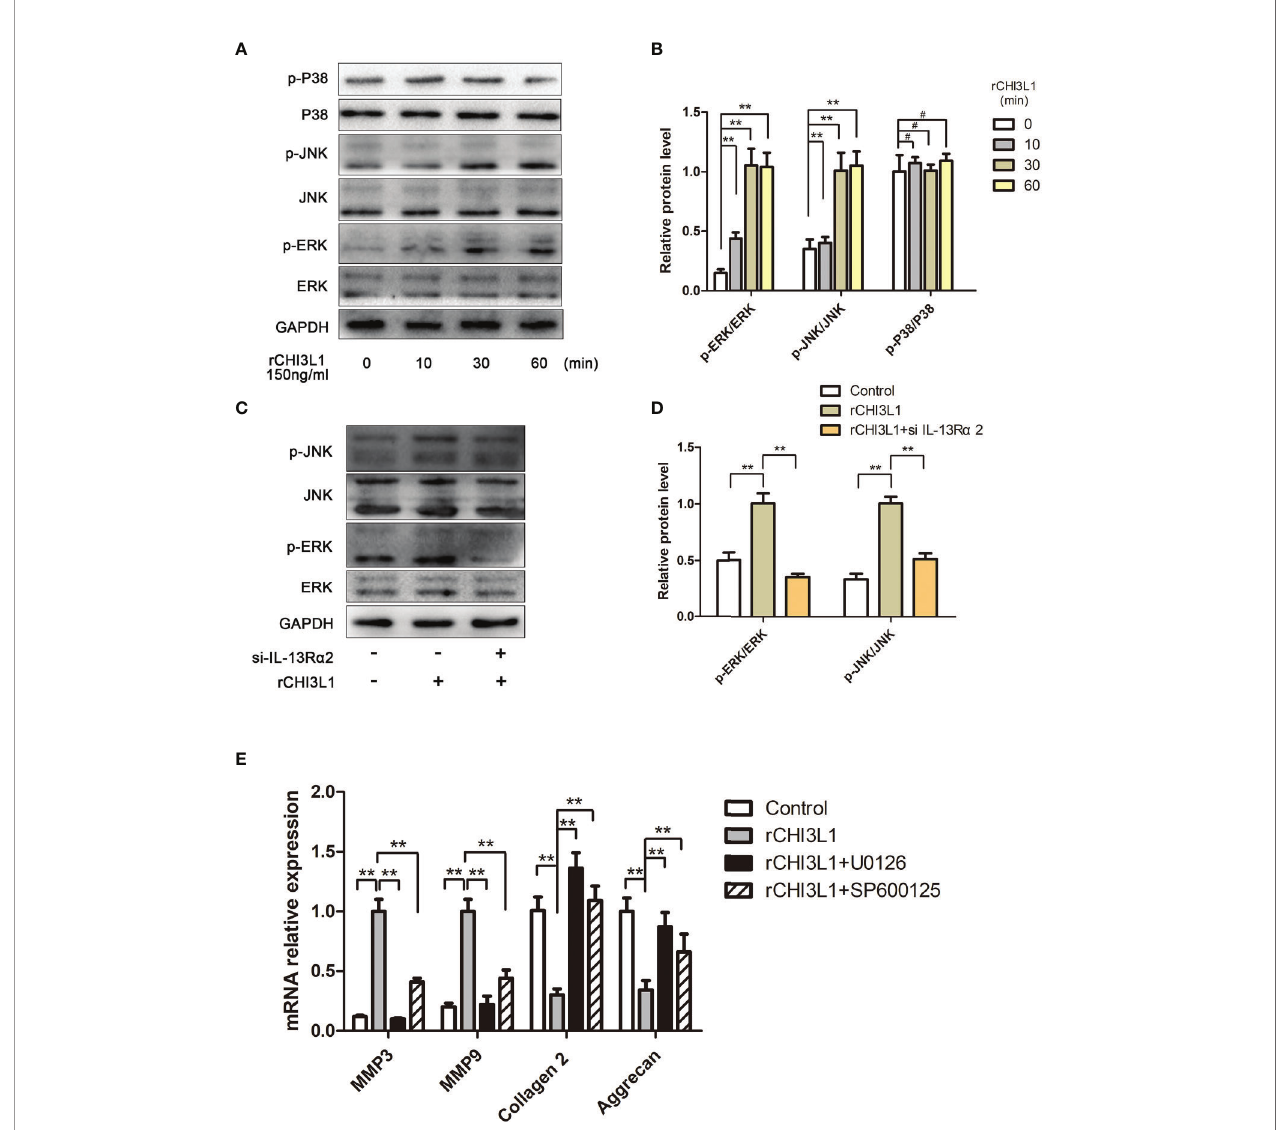
FIGURE 6 | CHI3L1 promoted ECM degradation through the MAPK pathway in NP cells. (A) CHI3L1 affected the MAPK pathway at different time points. NP cells were incubated with rCHI3L1 (150 ng/ml) at different time points (10, 30, and 60 min). The MAPK activation was detected by western blotting. (B) Quanti fi cation of the protein levels in (A, C) IL-13R a 2 was involved in the CHI3L1-induced activation of the MAPK pathway. The IL-13R a 2-silenced NP cells were incubated with rCHI3L1 (150 ng/ml) for 60 min. The MAPK pathway related proteins were detected by western blotting. (D) Quanti fi cation of the protein levels in (C). (E) The MAPK signaling pathway was involved in CHI3L1-induced ECM degradation. After treatment with U0126 (ERK inhibitor) or SP600125 (JNK inhibitor) at 10 µM for 6 h, NP cells were incubated with rCHI3L1 (150 ng/ml) for 24 h. MMP3, MMP9, collagen II, and aggrecan expression levels were analyzed by qRT-PCR. Data are presented as means ± standard deviations (n = 3) from one representative experiment of three independent experiments performed in triplicate. The dates were analyzed by One-way analysis of variance (ANOVA). Signi fi cant differences between groups are shown as **p < 0.01. #, no statistical